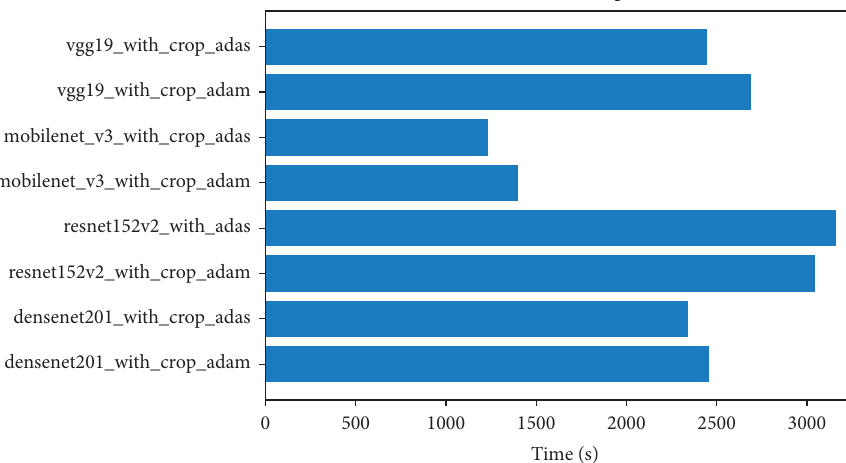
Figure 21: Training time over 100 epochs of network architectures with ADAM and ADAS optimization functions.